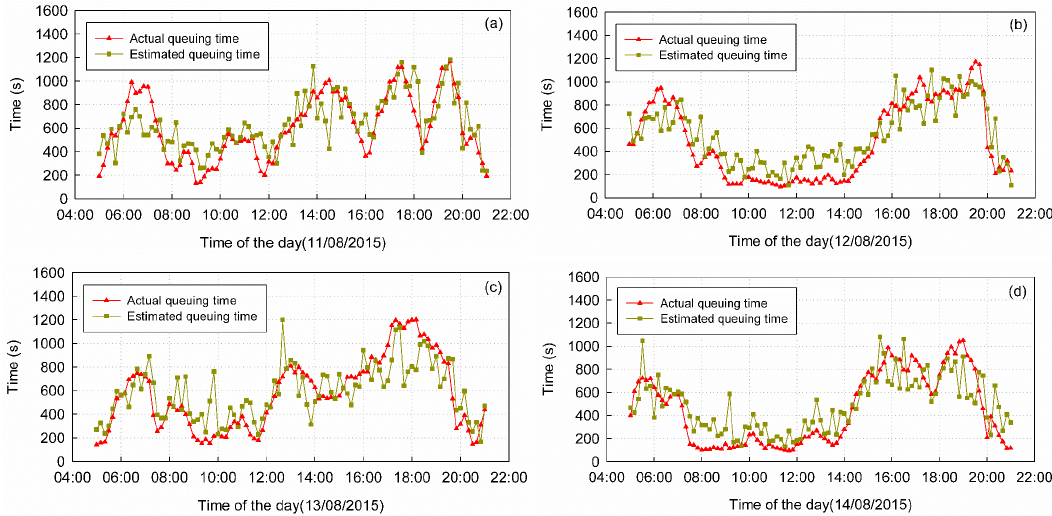
Figure 8. Comparison of the estimated and actual queuing times. ( a ) Comparison of the estimated and actual queuing times on 11 August; ( b ) Comparison of the estimated and actual queuing times on 12 August; ( c ) Comparison of the estimated and actual queuing times on 13 August; ( d ) Comparison of the estimated and actual queuing times on 14 August.